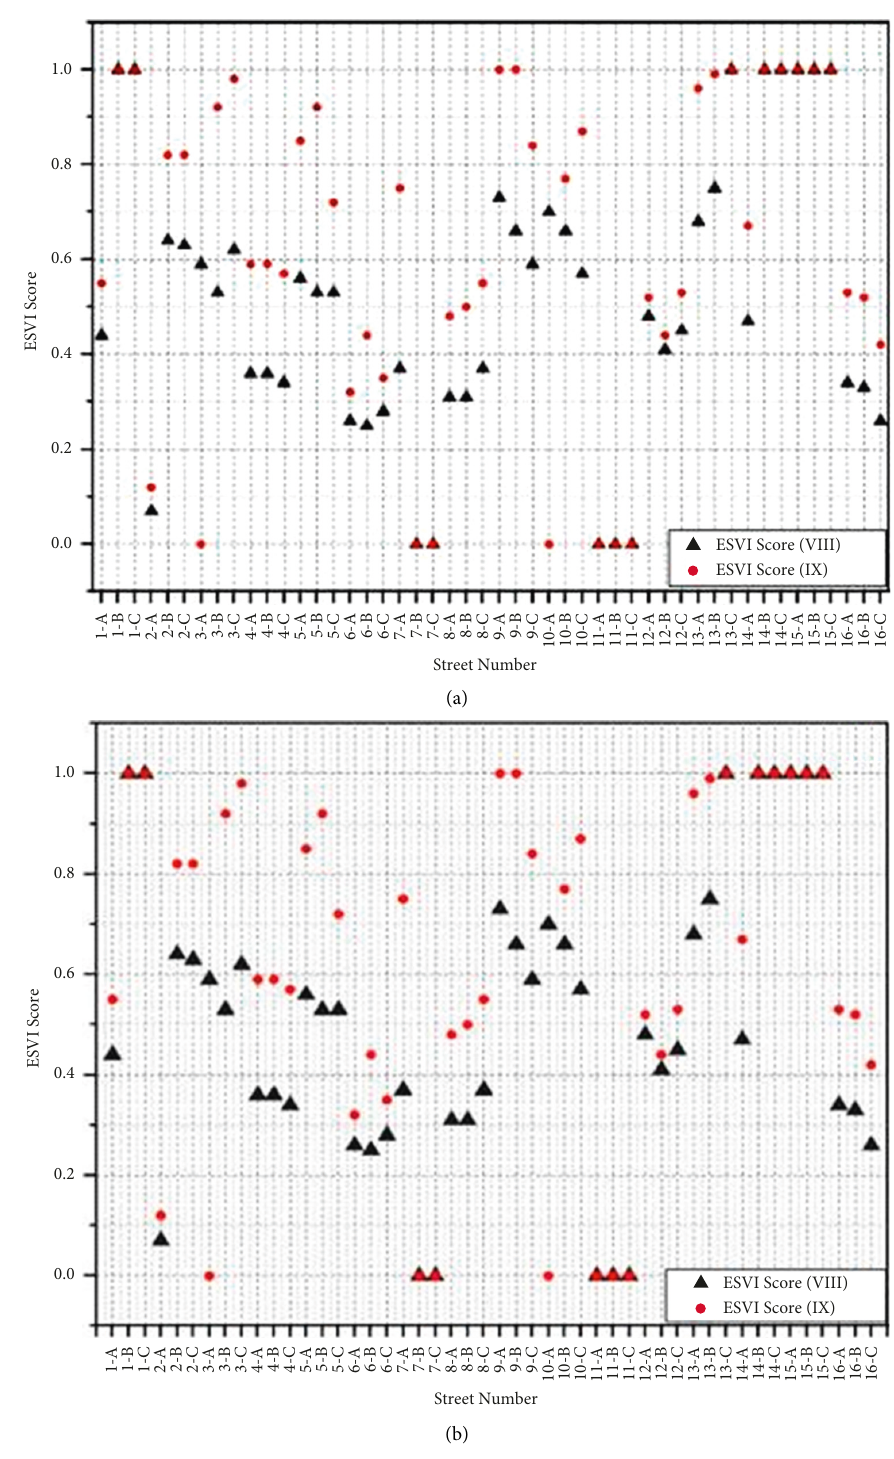
Figure 8: (a) ESVI scores for collapse type 1 at two different seismic intensity scenarios (IX) and (VIII). (b) ESVI scores for collapse type 2 at two different seismic intensity scenarios (IX) and (VIII): A for zone 1, B for zone 2, and C for zone